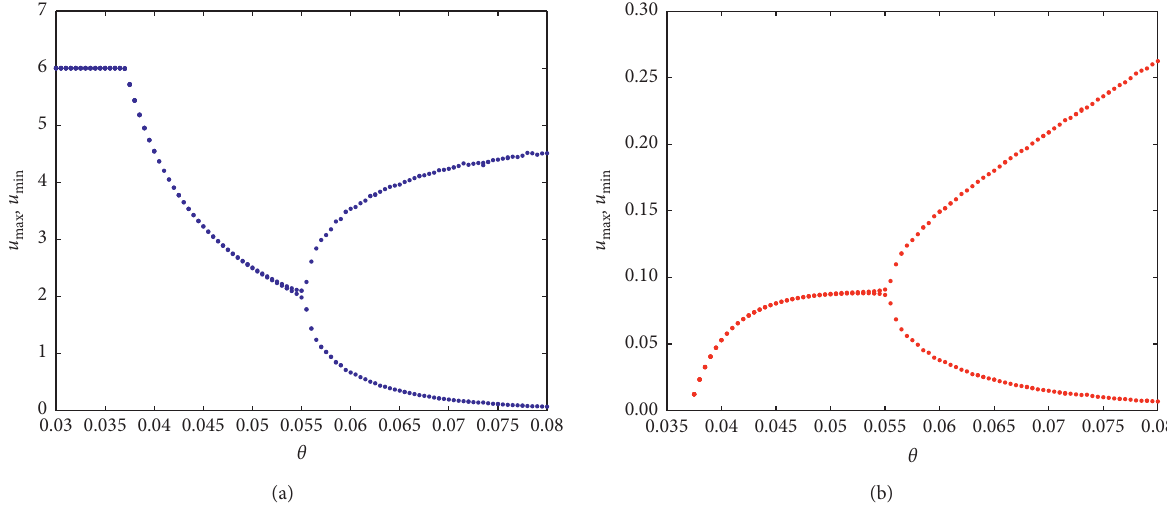
Figure 6: Bifurcation diagram with respect to conversion term θ for the predator-prey model (4) with Holling type-II response function. � 0 . 07, δ � 0 . 01, c � 0 . 01, α � 0 . 9, β � 0 . 5, and δ Rest of parameters: r 0 1